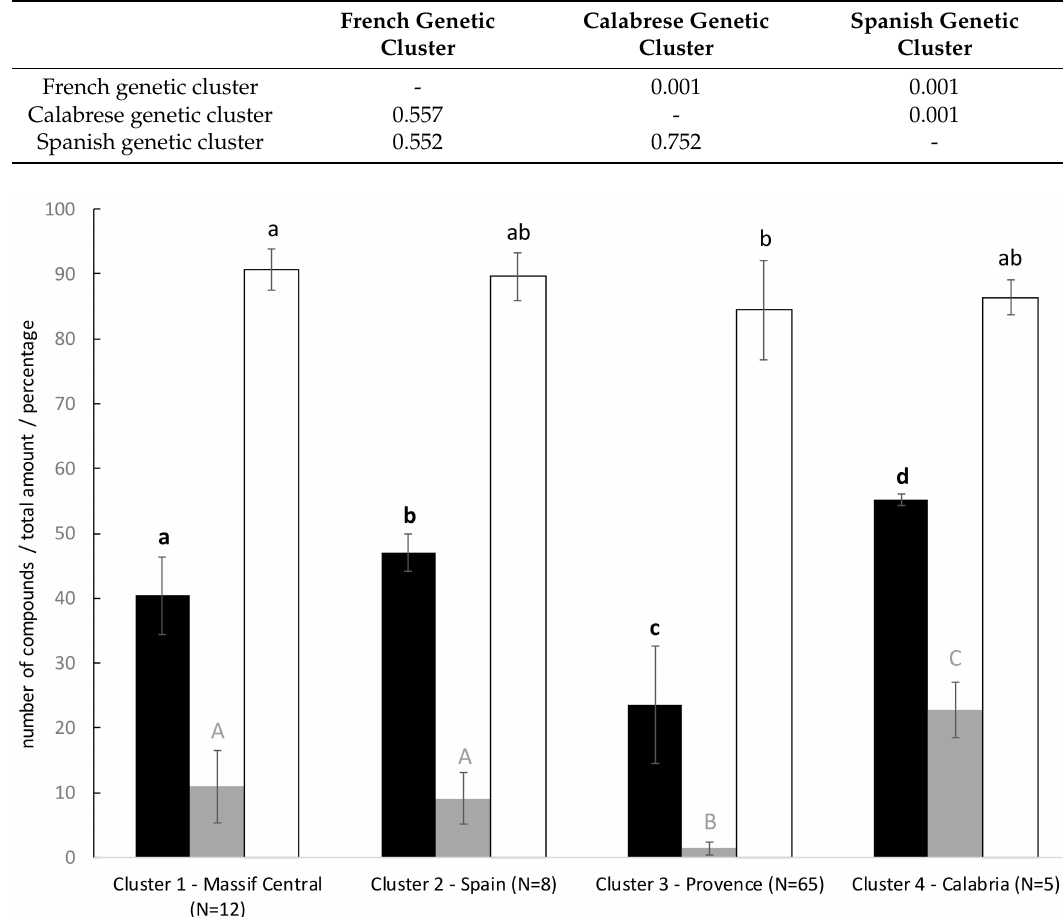
Figure 3. Number of compounds (black bars), total amount of volatile compounds (grey bars; internal standard equivalent per g of dry inflorescence) and percentage of monoterpenes (white bars) in the four clusters identified by DAPC on the chemical data. Black bold letters in the lower case indicate significant di ff erence in the number of compounds between clusters. Grey letters in the upper case indicate significant di ff erence for total amount of volatile compounds. Black letters in the lower case indicate significant di ff erence for percentage of monoterpenes. Pairwise comparisons were performed with pairwise Wilcoxon tests. The significance level was set to p =